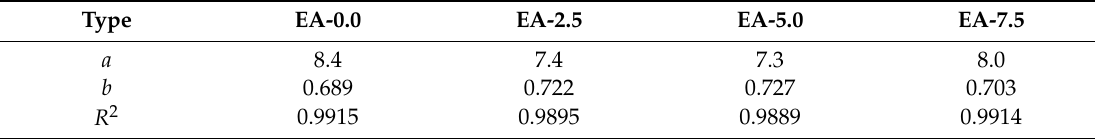
Table 4. Material constants of the modulus of elasticity of AAM